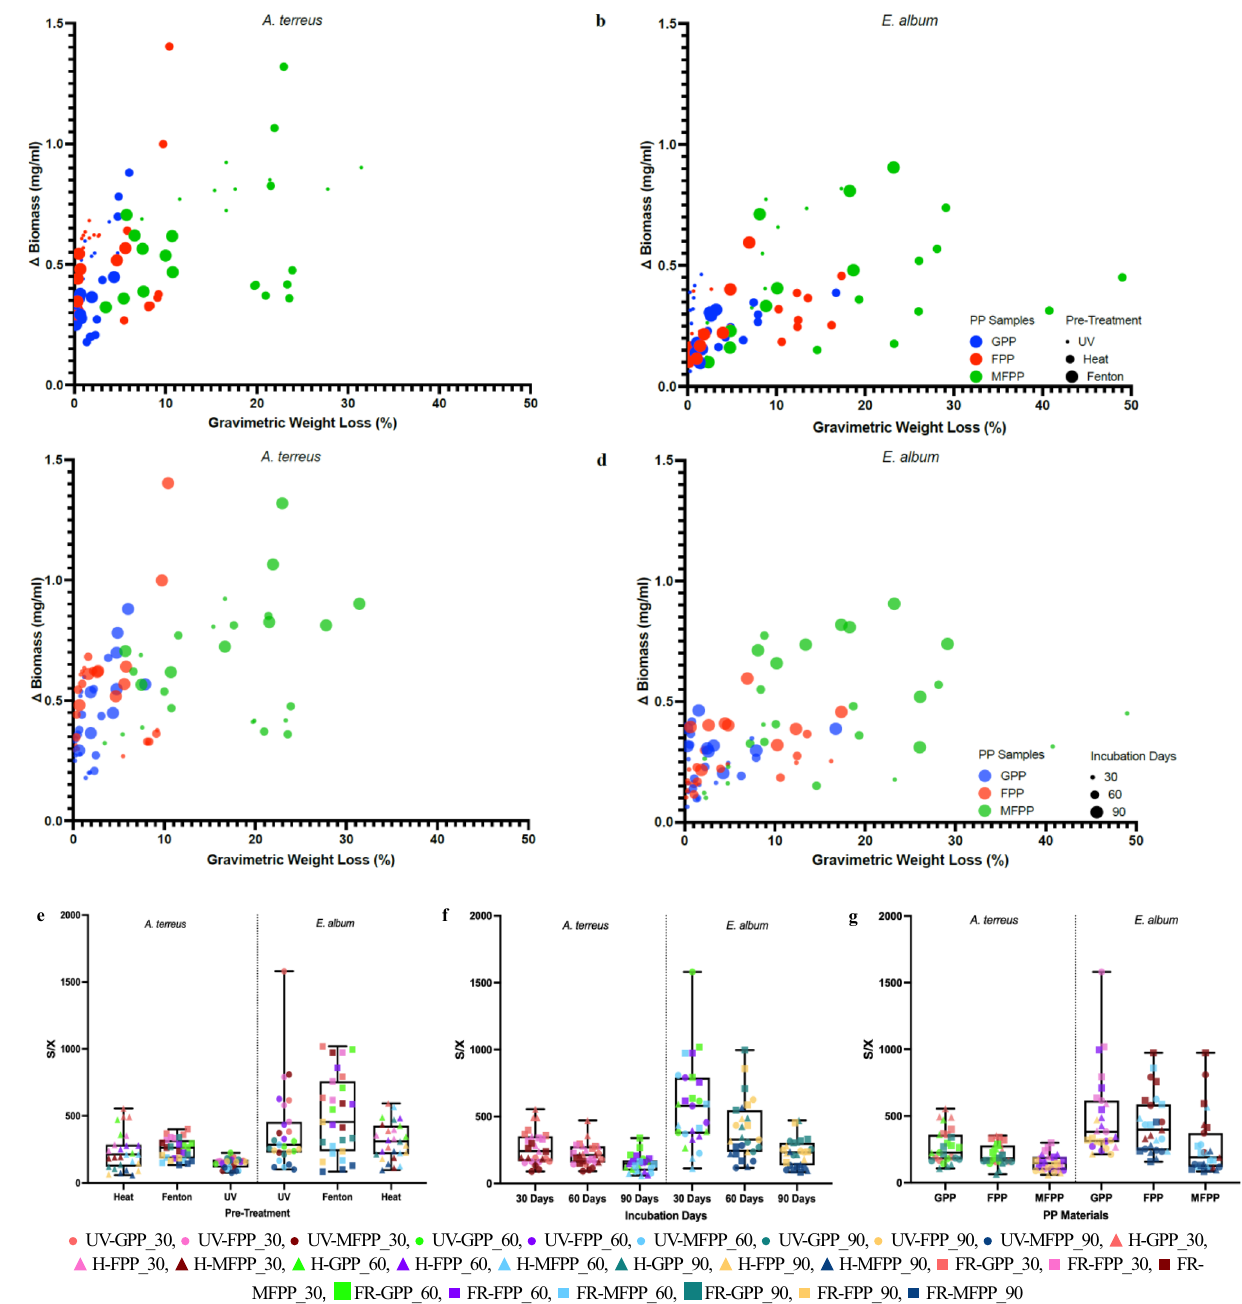
Fig. 3 Correlation analyses. a , b Biomass vs gravimetric weight loss of A. terreus a and E. album b PP samples and pre-treatment as factors. c , d Biomass vs gravimetric weight loss of A. terreus c and E. album d PP samples and incubation days as factors. e – g S (gravimetric weight loss)/X ( Δ biomass) of A. terreus and E. album vs pre-treatments e , vs incubation days f and vs PP materials g . GPP PP granule, FPP PP fi lm, MFPP PP metallised fi lm, UV UV treatment, H heat treatment, FR Fenton reagent Statistical parameters represent the goodness of fi t data. Supplementary Fig. 1 shows the correlation matrix for both fungi. All data lie within a 95% con fi dence interval.